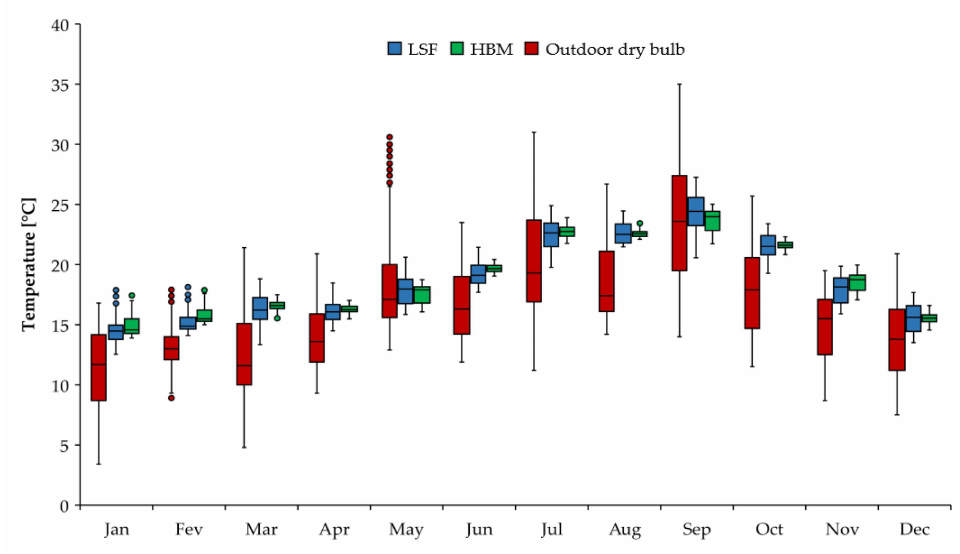
Figure 8. Monthly box plot representation of the indoor air temperatures and outdoor dry bulb